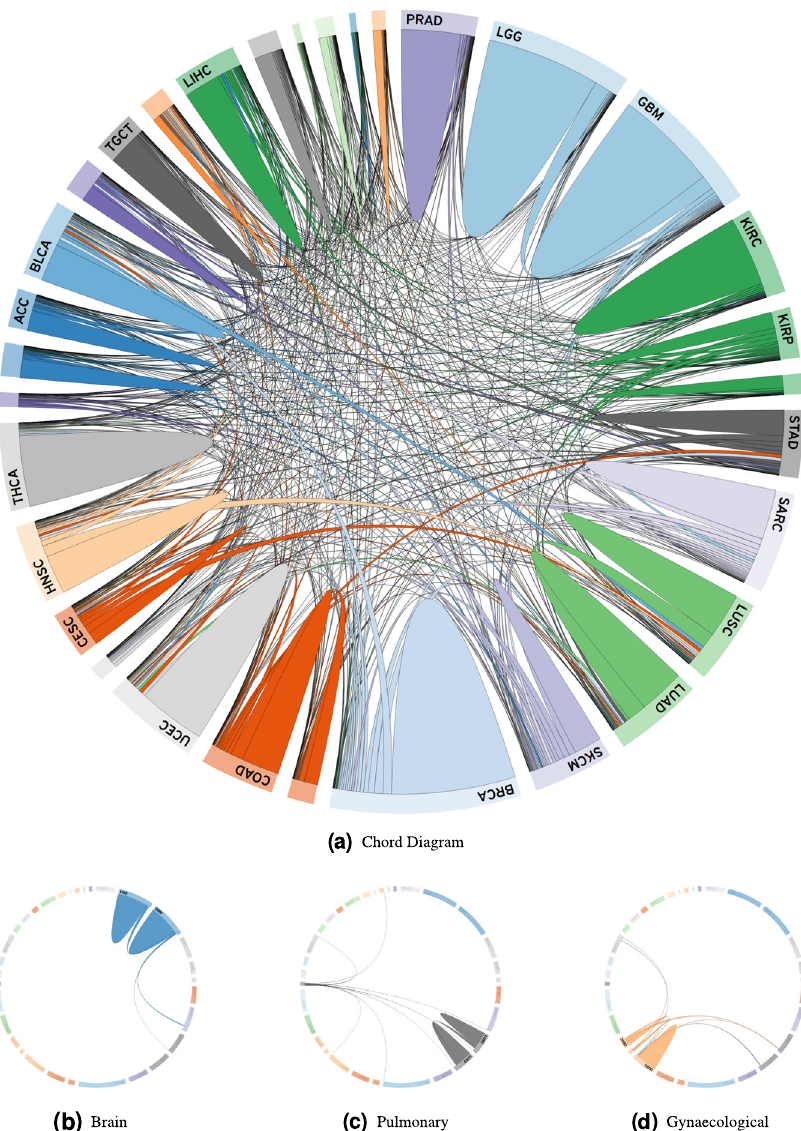
Fig. 8 Horizontal search. a Chord diagram of horizontal image search for diagnostic slides of the TCGA data set. Sample relations for ( b ) brain (LGG and GBM), ( c ) pulmonary (LAUD, LUSC, and MESO), and ( d ) gynecological (UCEC, UCS, and CESC). The chord diagram can be interactively viewed online: